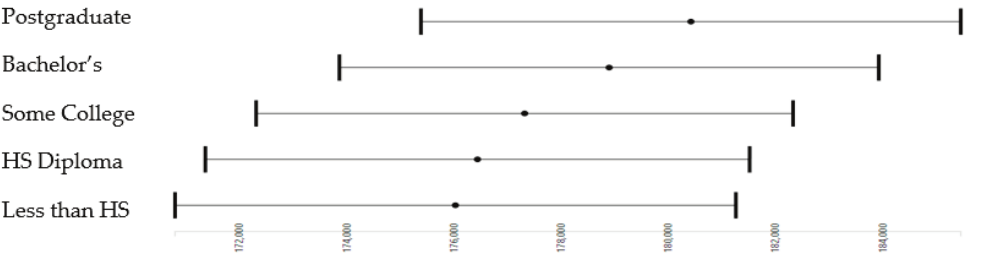
Figure 2. E ff ects of parental education on the whole-brain cortical surface area in the overall sample. HS: High